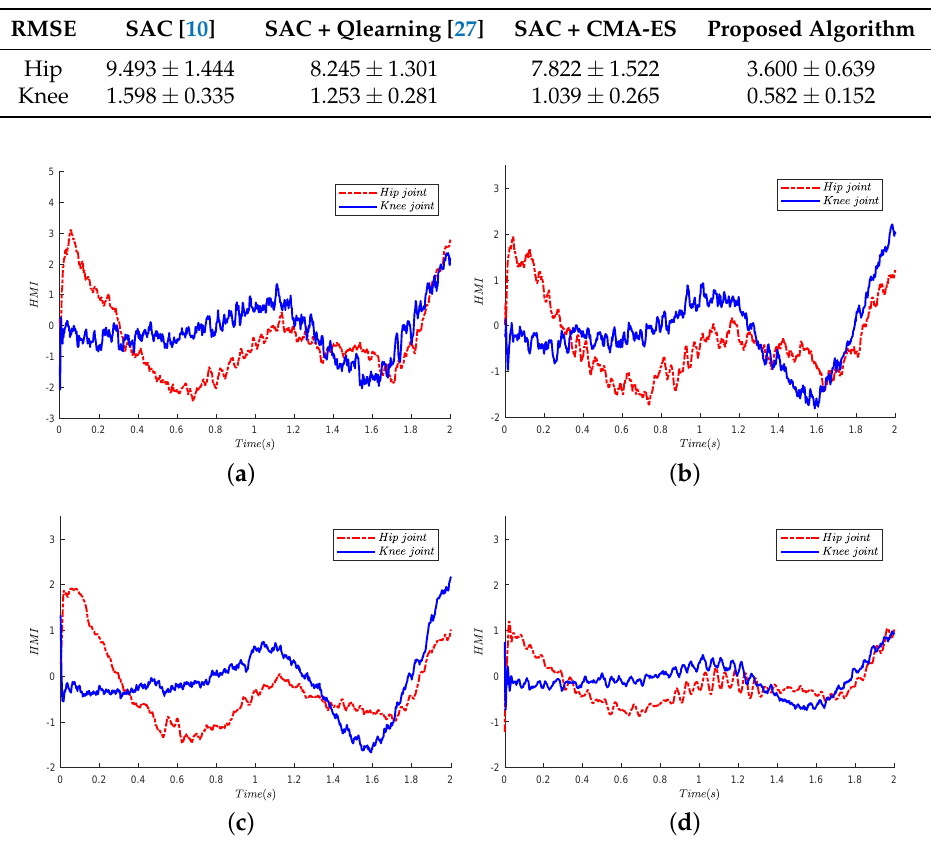
Figure 13. The HRI comparison of four control algorithms. ( a ) SAC; ( b ) SAC + Qlearning; ( c ) SAC + CMA-ES; ( d ) proposed algorithm. Note that the HRI force is estimated by the disturbance observer since there is no sensor mounted between the human and